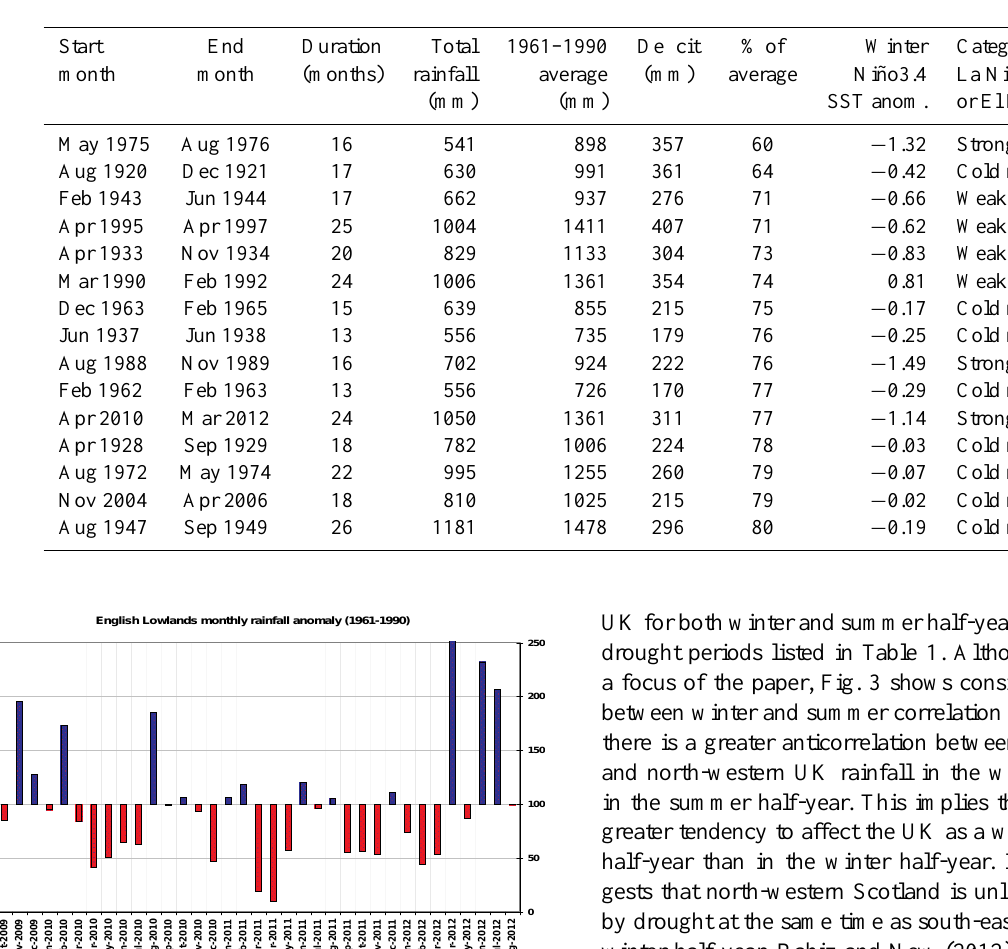
Table 1. Fifteen key 13 to 26 month duration meteorological droughts across the English Lowlands, 1910 to 2012, based on NCIC gridded rainfall data. Table 1 is ordered by drought severity, expressed as a percentage of long-term average rainfall. The Niño3.4 SST anomaly is the average for all winter half-year months during the drought.